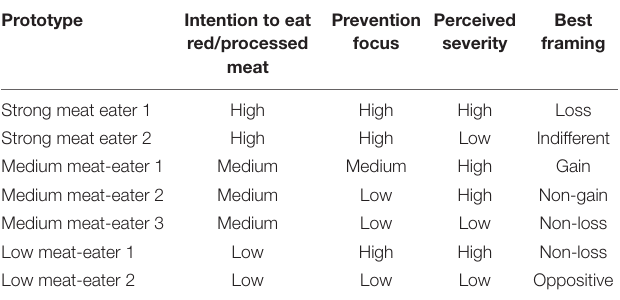
TABLE 2 | Best message framing as a function of prototypes emerged from clustering analysis.